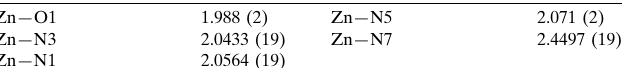
Selected bond lengths (A˚ ).